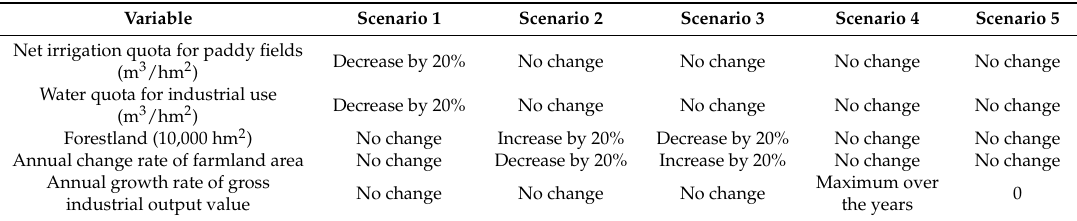
Table 2. Different